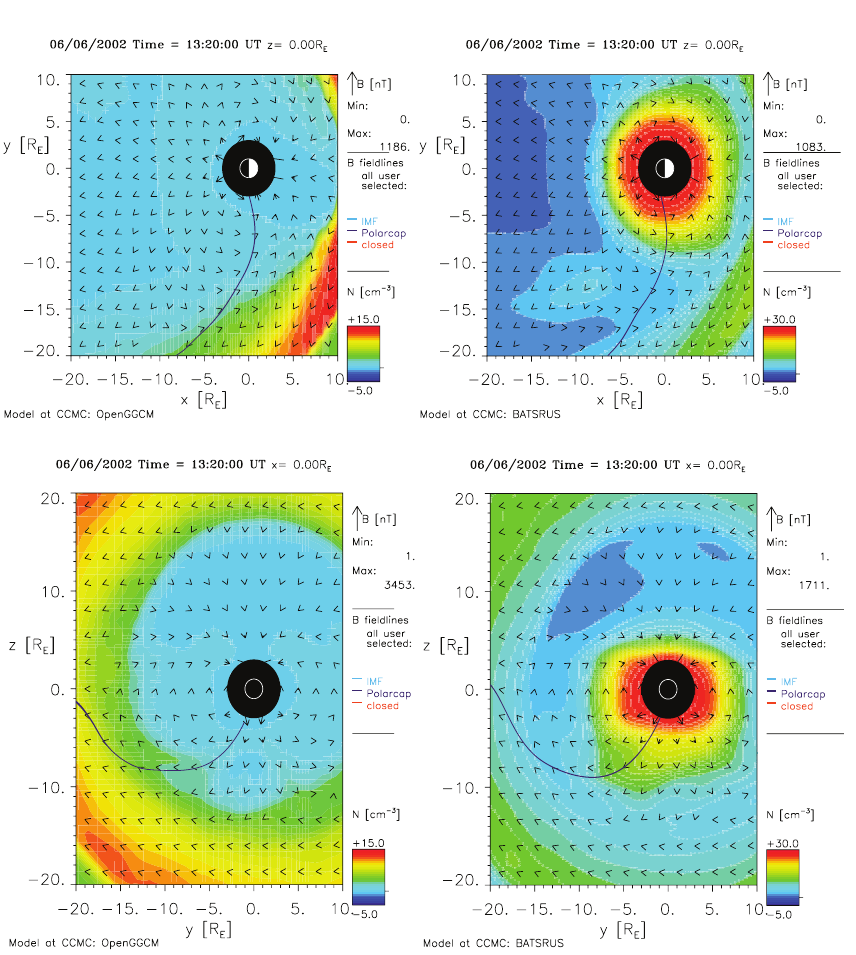
Fig. 3. Mapped field line positions of Event 3 at 13:20UT for OpenGGCM and BATS-R-US. The top- and bottom-left images were produced from OpenGGCM and the top- and bottom-right images were produced from BATS-R-US. The spacecraft coordinates can be references from Table 1. Each panel illustrates the magnetic field direction using a black arrow and density using the color bar.